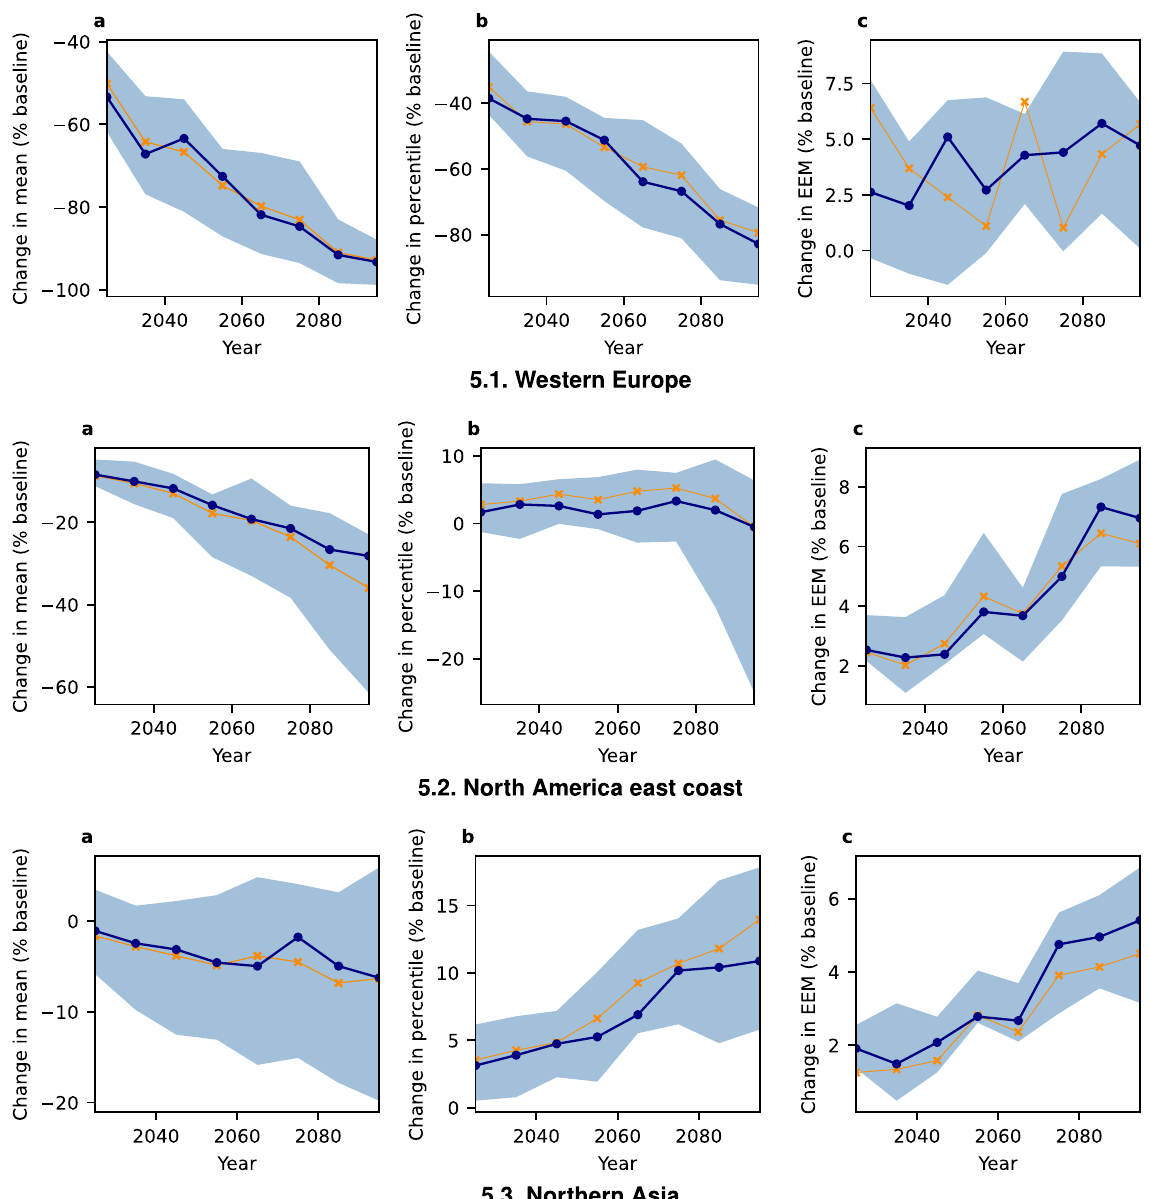
Figure 5. Regional differences of changes in daily snowfall statistics (elevation below 1000 m, decadal statistics, SSP5-RCP8.5). All values are relative to the baseline (1851–1920) climate. ( a ) Mean, ( b ) 99.9th percentile, ( c ) expected extreme magnitude above the 99.9th baseline percentile. Blue line shows the model ensemble median, shaded areas denote the likely range (16.7th to 83.3rd percentiles). Orange line shows statistics for all ten models combined into one time series